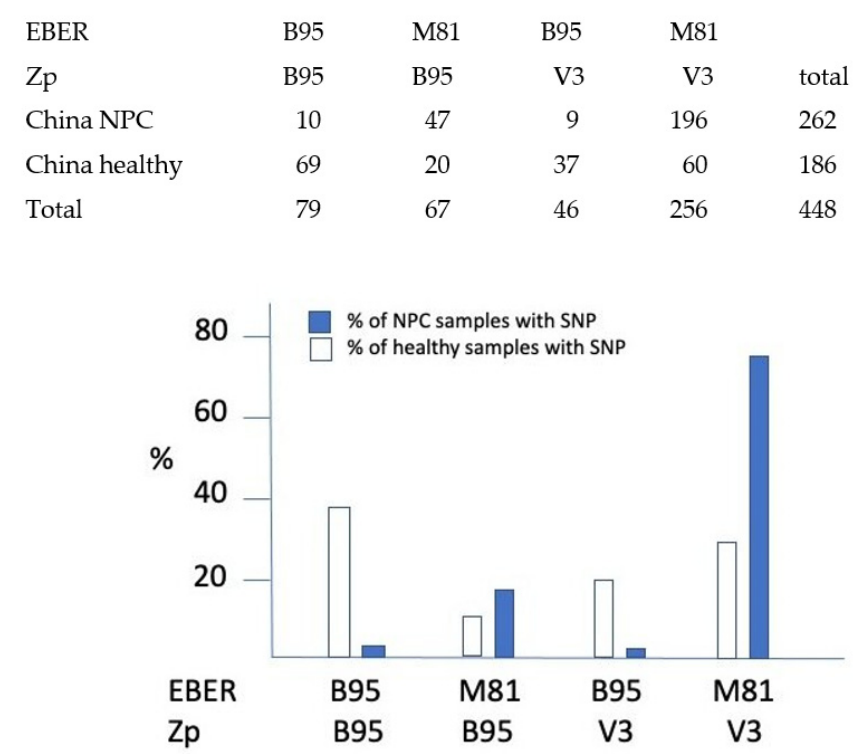
Figure 3. Incidence of the different combinations of EBER2 and Zp SNPs in Chinese EBV strains, comparing viruses from NPC disease with healthy controls. x -axis shows the different possible combinations of Zp and EBER SNPs, classified into either B95 (the sequence of the reference B95-8 western strain) or the Zp-V3 and EBER2-M81 SNPs described in the text. Chi squared test shows a highly significant increase ( p = 1 × 10 − 27 ) in NPC cases in people whose EBV contains both EBER2-M81 and Zp-V3 SNPs.